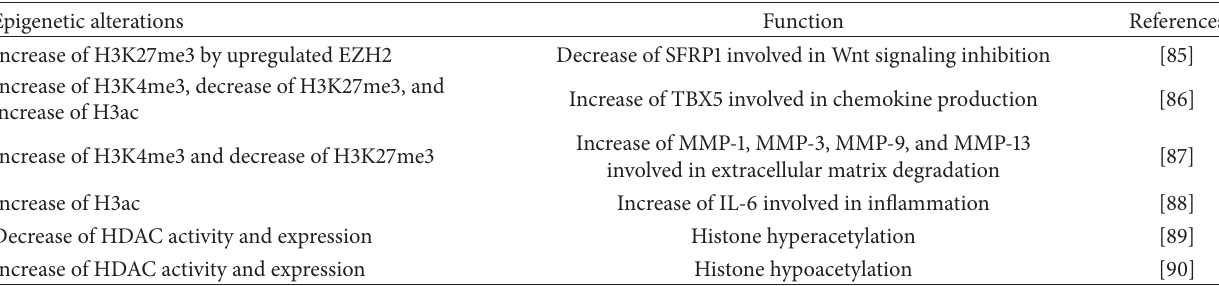
Table 1: Abnormality of histone modifications in RASFs.